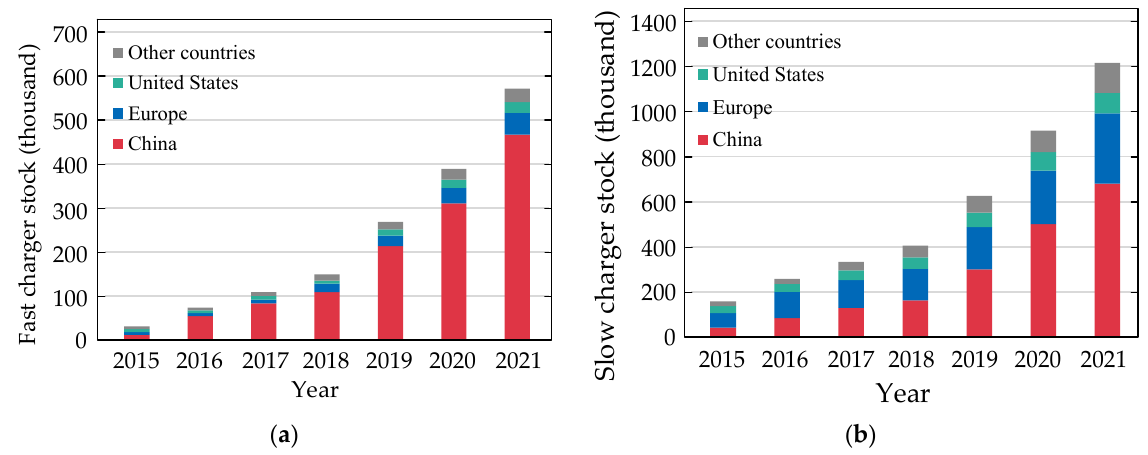
Figure 2. Public electric vehicle charging system by power level and region (2015–2021). ( a ) Publicly available fast chargers. ( b ) Publicly available slow chargers.